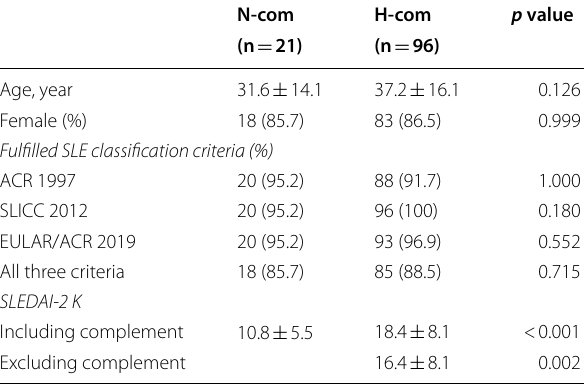
SLE Systemic lupus erythematosus; N-com Normal serum levels of C3, C4, and CH50; H-com Less than normal serum levels of one or more complements in C3, C4, and/or CH50; ACR American College of Rheumatology; SLICC Systemic Lupus International Collaborating Clinics; EULAR , European League